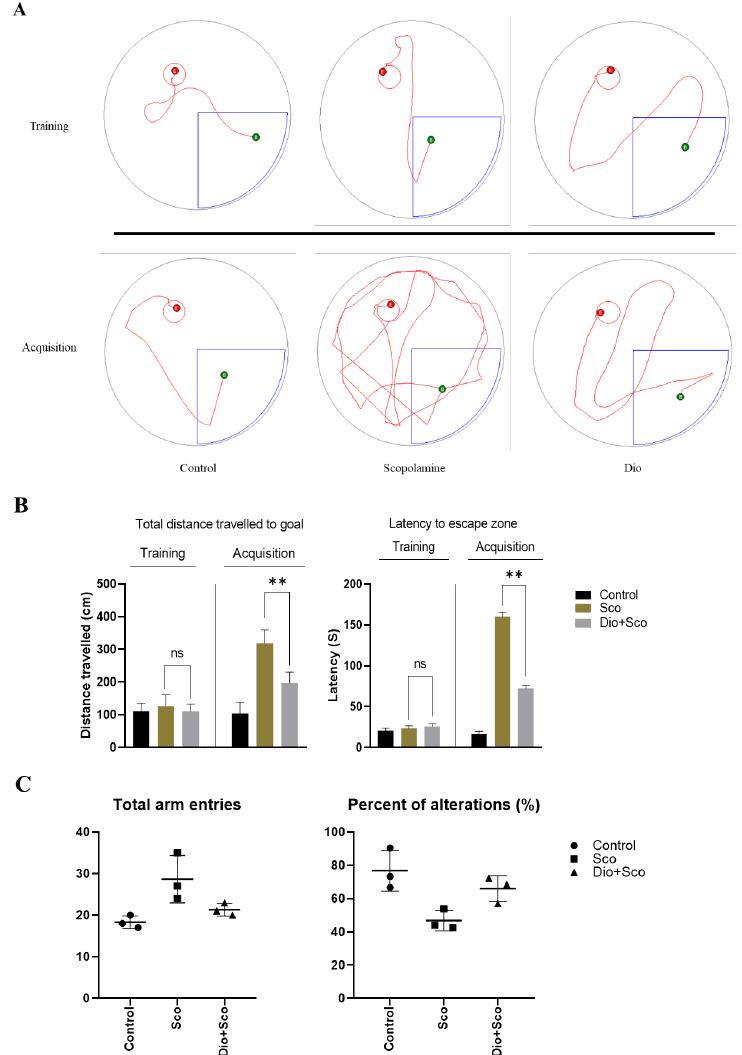
Figure 5. Dioscin effect on scopolamine-induced amnesic mice model. ( A ) Trajectory map used by animals during training and data acquisition in MWM pool; B = starting point and E = hidden plat-